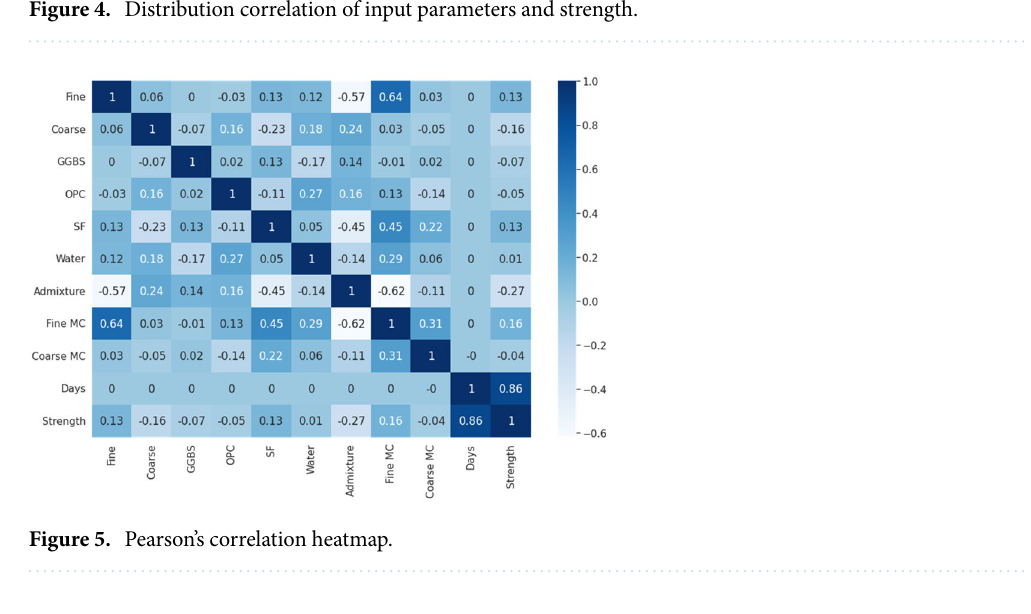
Figure 4. Distribution correlation of input parameters and strength.